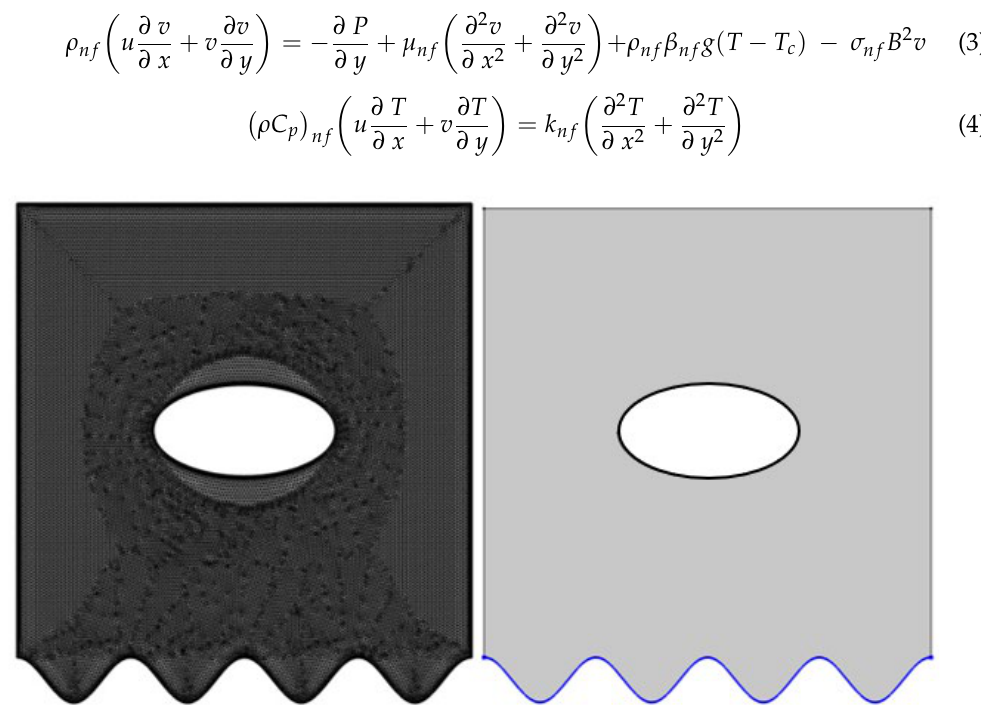
Figure 1. Physical model and mesh.